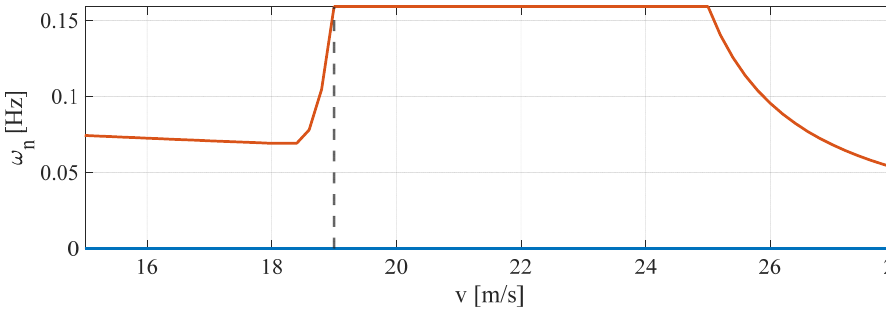
Figure 13. Damping ratio and frequency variations of the closed-loop system.